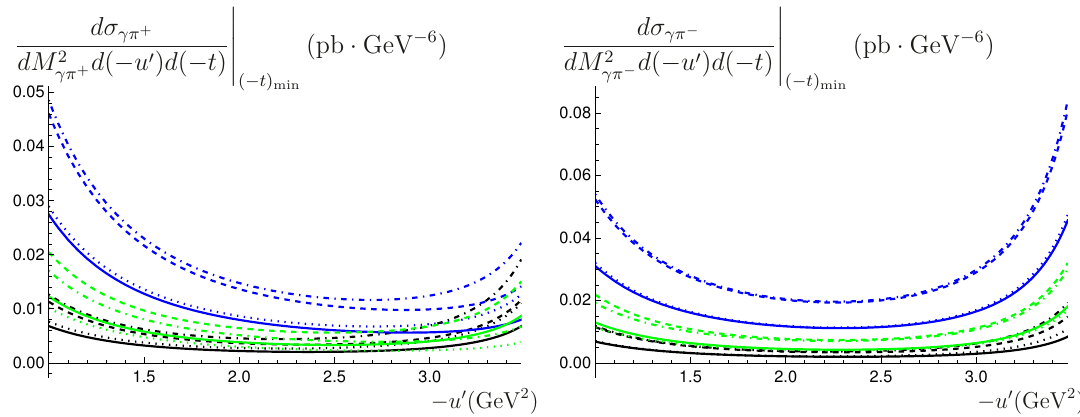
Figure 25 . The fully differential cross-section for π + ( π − ) is shown as a function of ( − u 0 ) on the left (right). The blue and green curves correspond to contributions from the u quark ( H quark ( H and ˜ H ) GPDs respectively. The black curves correspond to the total contribution. The d d dashed (non-dashed) lines correspond to holographic (asymptotic) DA, while the dotted (non-dotted) lines correspond to the standard (valence) scenario. We fix S Similar comments as in figure 15